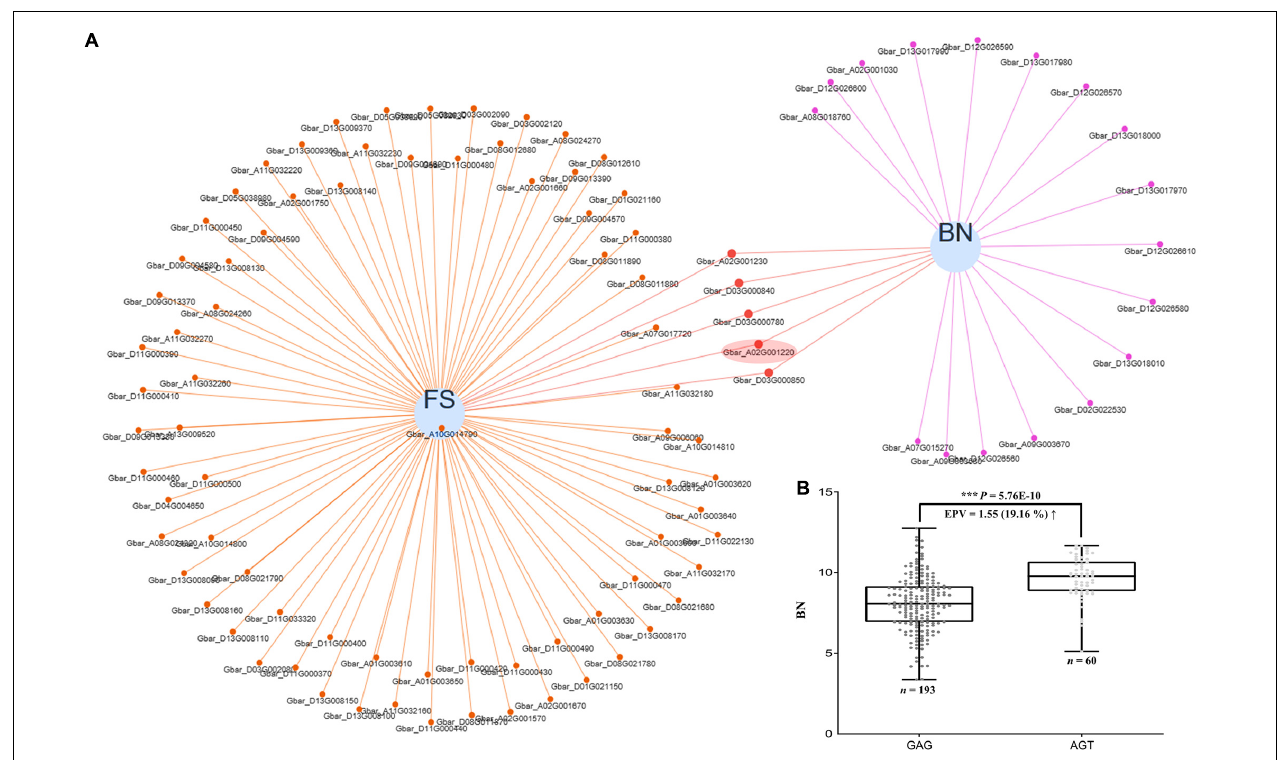
FIGURE 7 | Pleiotropic genes acting on both fiber strength and boll number, and the effect of GbCML7 haplotype shift on boll number. (A) Venn network showing putative pleiotropic genes for fiber strength (FS) and boll number (BN). Each blue circle represents one trait. Genes related to each specific trait are indicated as small solid spots, which are linked to the corresponding trait circle using colored lines. Small solid spots linked to two traits are regarded as putative pleiotropic genes. Fiber strength candidate gene, GbCML7 ( Gbar_A02G001220 ) is highlighted in a red ellipse. (B) Boll number in accessions with the two main haplotypes of GbCML7 ( Gbar_A02G001220 ). n represents the number of accessions with that specific haplotype. Each point represents one accession. Accessions with the haplotype GAG are in dark gray and those with haplotype AGT are in light gray. Boxes span the first to third quartiles, center lines represent median values, and whiskers show the minimum and maximum. *** indicates the significant difference at P <